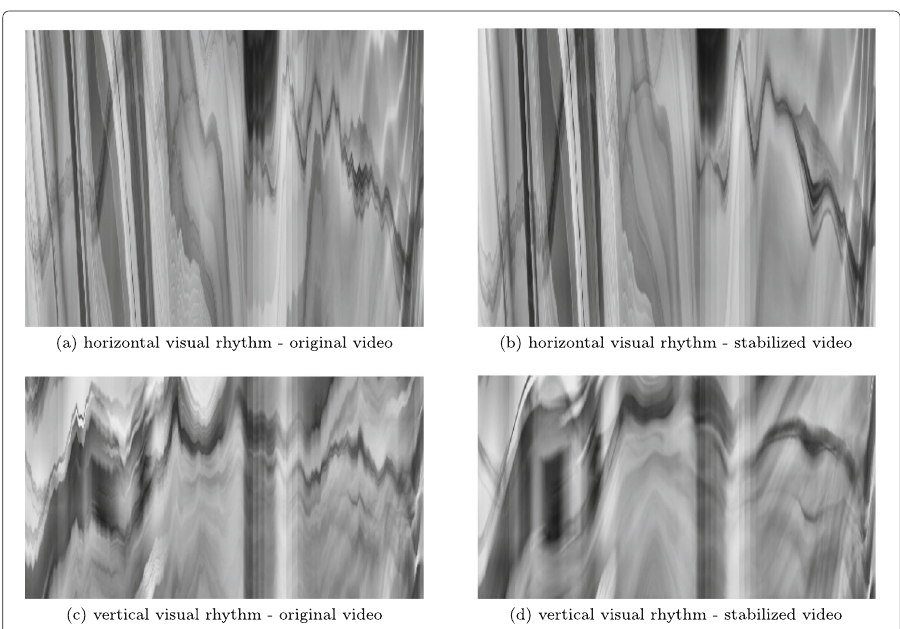
Fig. 16 Visual rhythms for video with moving object on low-texture background. a Horizontal visual rhythm for original video. b Horizontal visual rhythm for stabilized video. c Vertical visual rhythm for original video. d Vertical visual rhythm for stabilized video